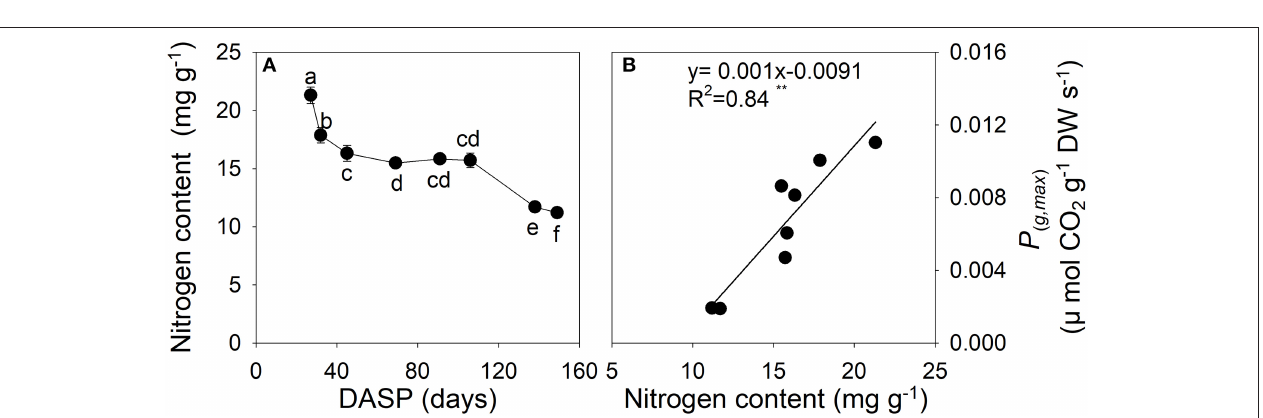
FIGURE 7 | Nitrogen content (A) and the correlation between the maximal rate of gross photosynthesis at light saturation P ( g,max ) per dry weight, and nitrogen content (B) in sarcotesta of seeds of Torreya grandis cv. “Merrillii” during seed development in 2015. In (A) the mean ± SD is indicated. Different letters denote significant differences at P ≤ 0.05 level. n = 4 trees. DASP, days after seed protrusion. The solid line represent the best-fit linear regressions between the maximal rate of gross photosynthesis at light saturation P ( g , max ) per dry weight, and nitrogen content: * P ≤ 0.05; ** P ≤ 0.01; *** P ≤ 0.001; ns, not